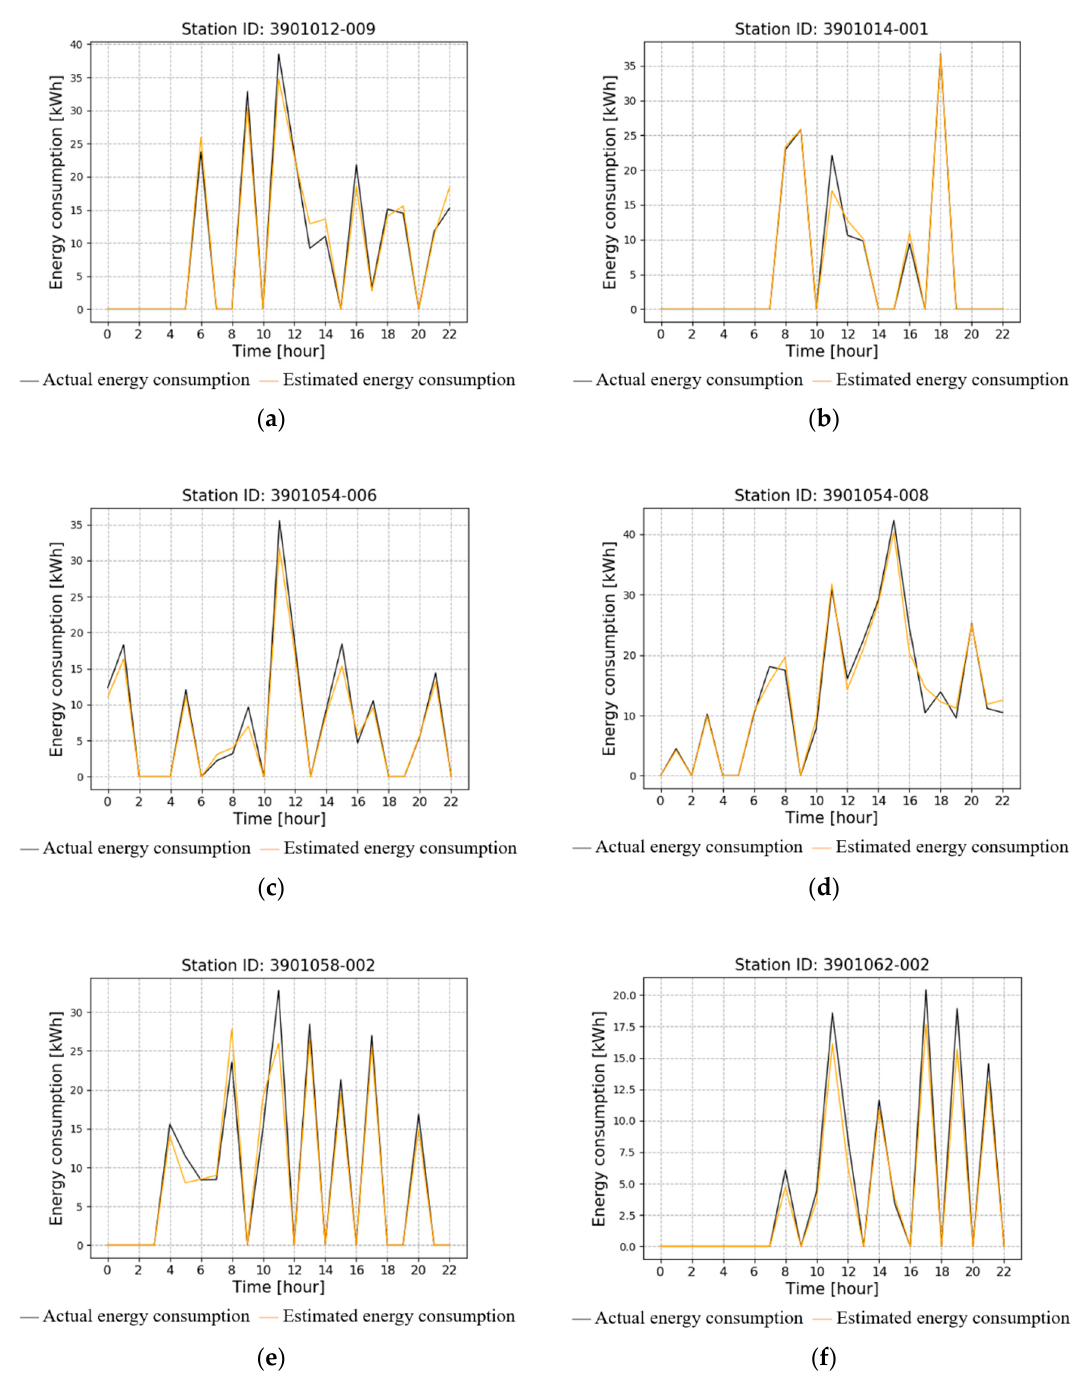
Figure 13. The first display example: graphs of estimated electricity consumption value in a relation to time (hour) for each station. Station ID: ( a ) 3901012-009; ( b ) 3901014-001; ( c ) 3901054-006; ( d ) 3901054-008; ( e ) 3901058-002; ( f )